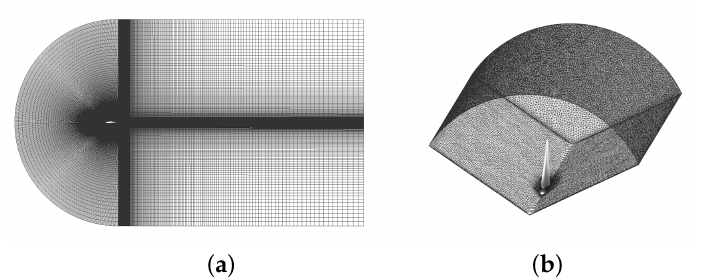
Figure 2. HAWT-S826: Computational mesh for the simulation of flow around the ( a ) Case-I: S826 airfoil. The computational mesh consists of 8.2 × 10 4 cells. ( b ) Case-III: the 120 ◦ blade. The hybrid computational mesh consists of 4.8 × 10 5